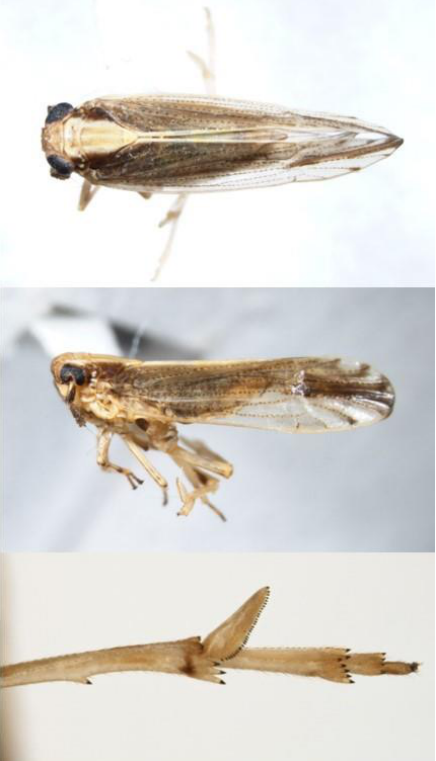
Figure 5. Perkinsiella saccharicida adult dorsal view (top), lateral view (middle), and hind tibia spur (bottom). Photos: © C. Bartlett and K. Shropshire, University of Delaware.